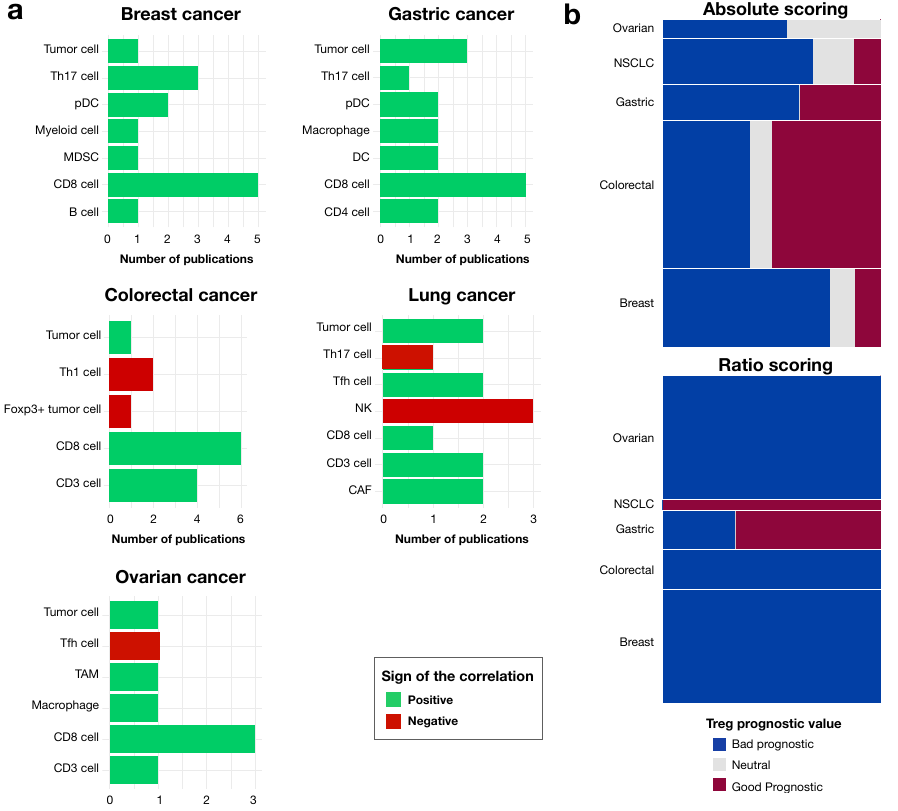
Figure 4. Interplay between Tregs and neighboring cells. ( a ) Correlation between Tregs and other cell populations, by cancer type; number of articles depicting the various correlations. ( b ) Treemap of the prognostic value of Tregs by type of quantification: absolute quantification (top panel) or quantification via the determination of a ratio (considering all Treg/neighboring cell ratios) (bottom panel). The length of each bar represents the proportion of patients for each prognostic value by cancer type, and the height of each rectangle indicates the proportion of patients from each cancer type (n = 14,565 for absolute quantification, n = 3653 for ratio